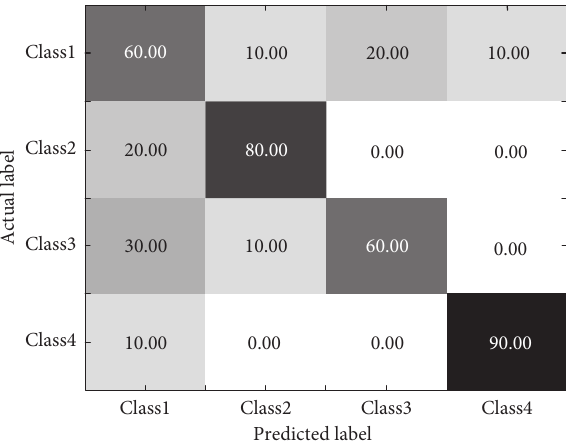
Figure 17: The confusion matrix of the classification